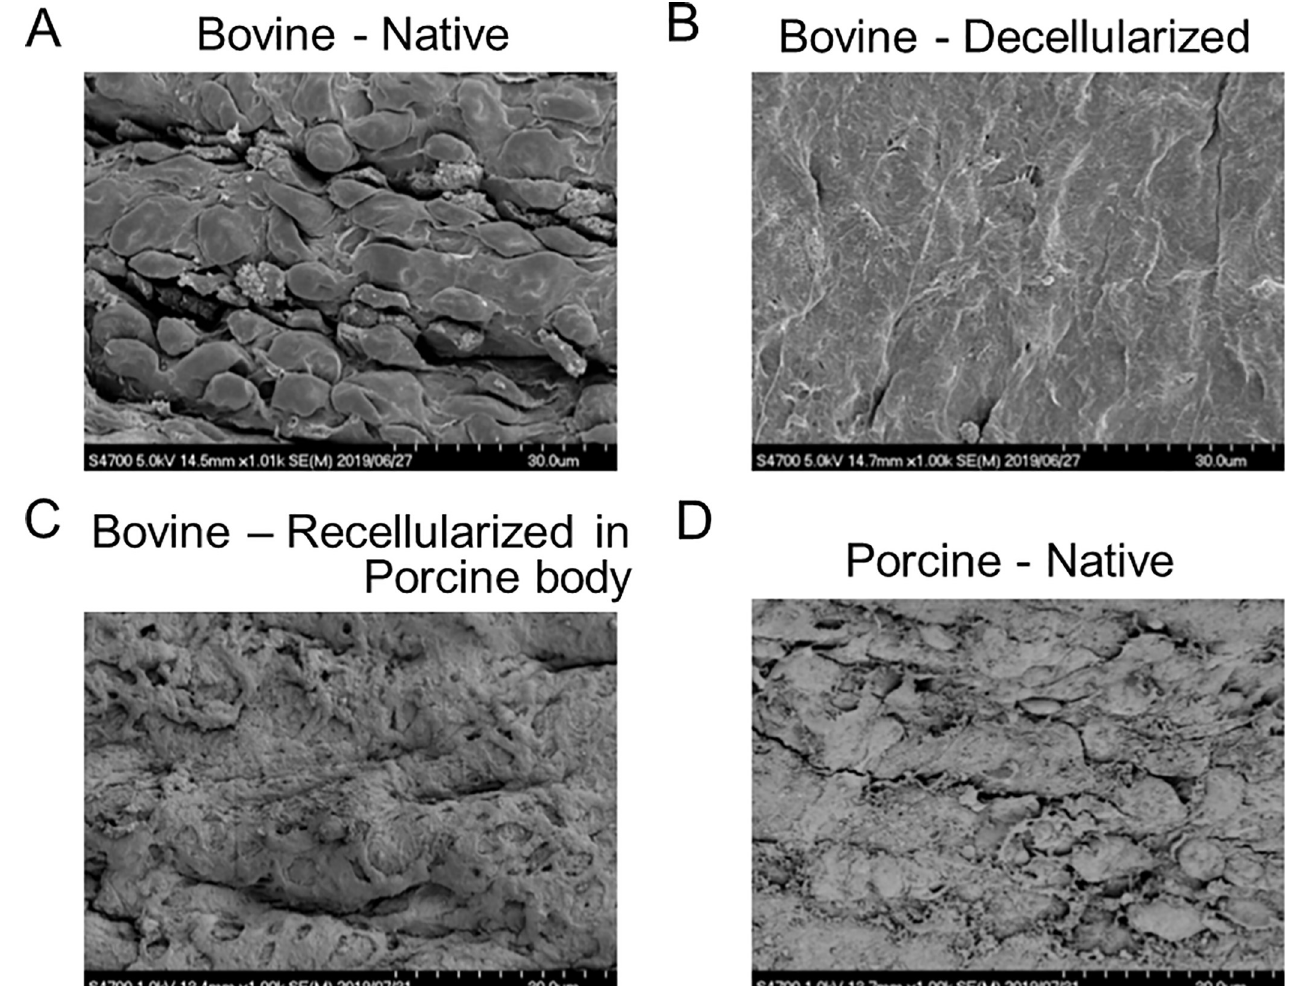
Fig 5. Evaluation of endothelial formation by scanning electron microscopy. ( A ) Representative luminal surface of untreated bovine artery. ( B ) Representative luminal surface of decellularized bovine artery. ( C ) Representative luminal surface of explanted graft. ( D ) Representative luminal surface of native porcine carotid